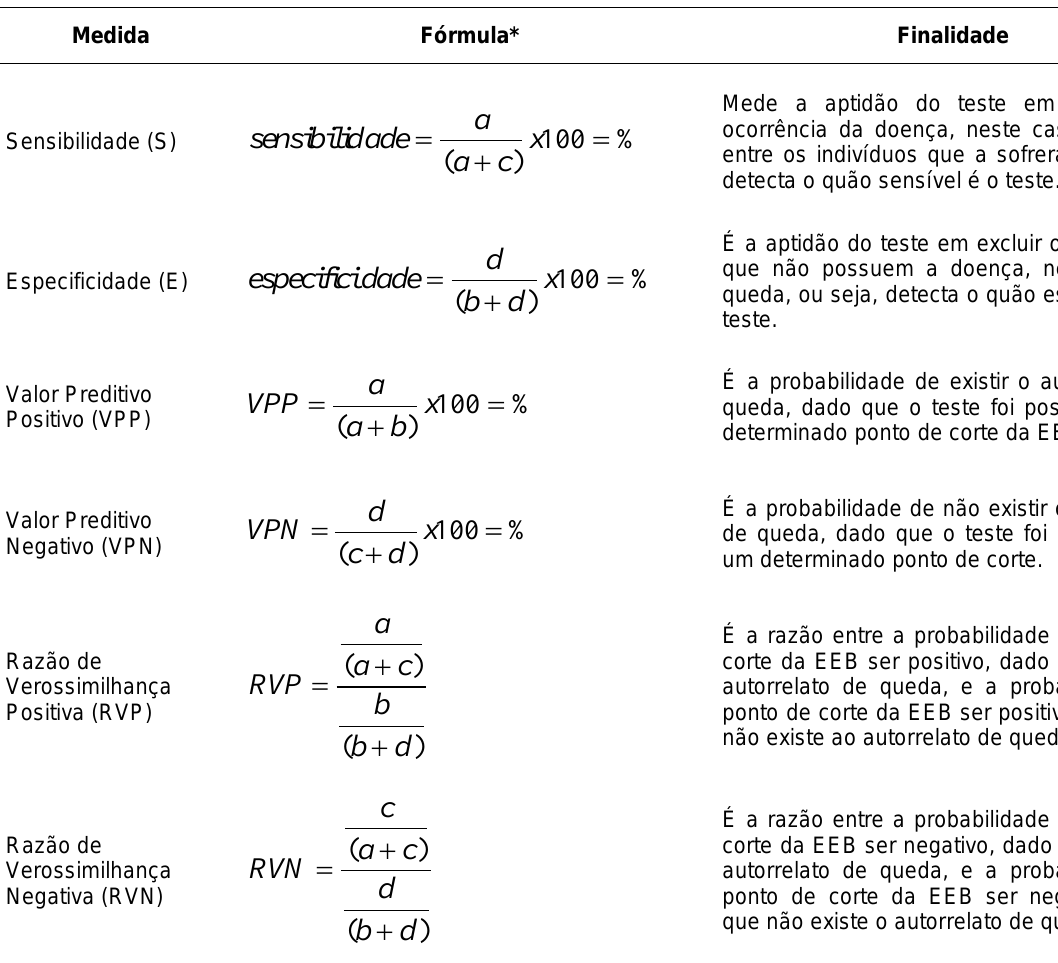
Tabela 2. Símbolo, fórmula e finalidade das medidas de qualidade: sensibilidade (S), especificidade (E), valor preditivo positivo (VPP) e negativo (VPN) do teste, razão de verossimilhança positiva (RVP) e negativa